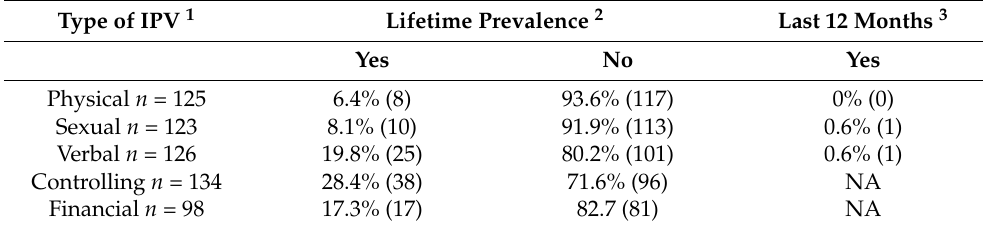
Table 2. Prevalence of ever-partnered men perpetrating